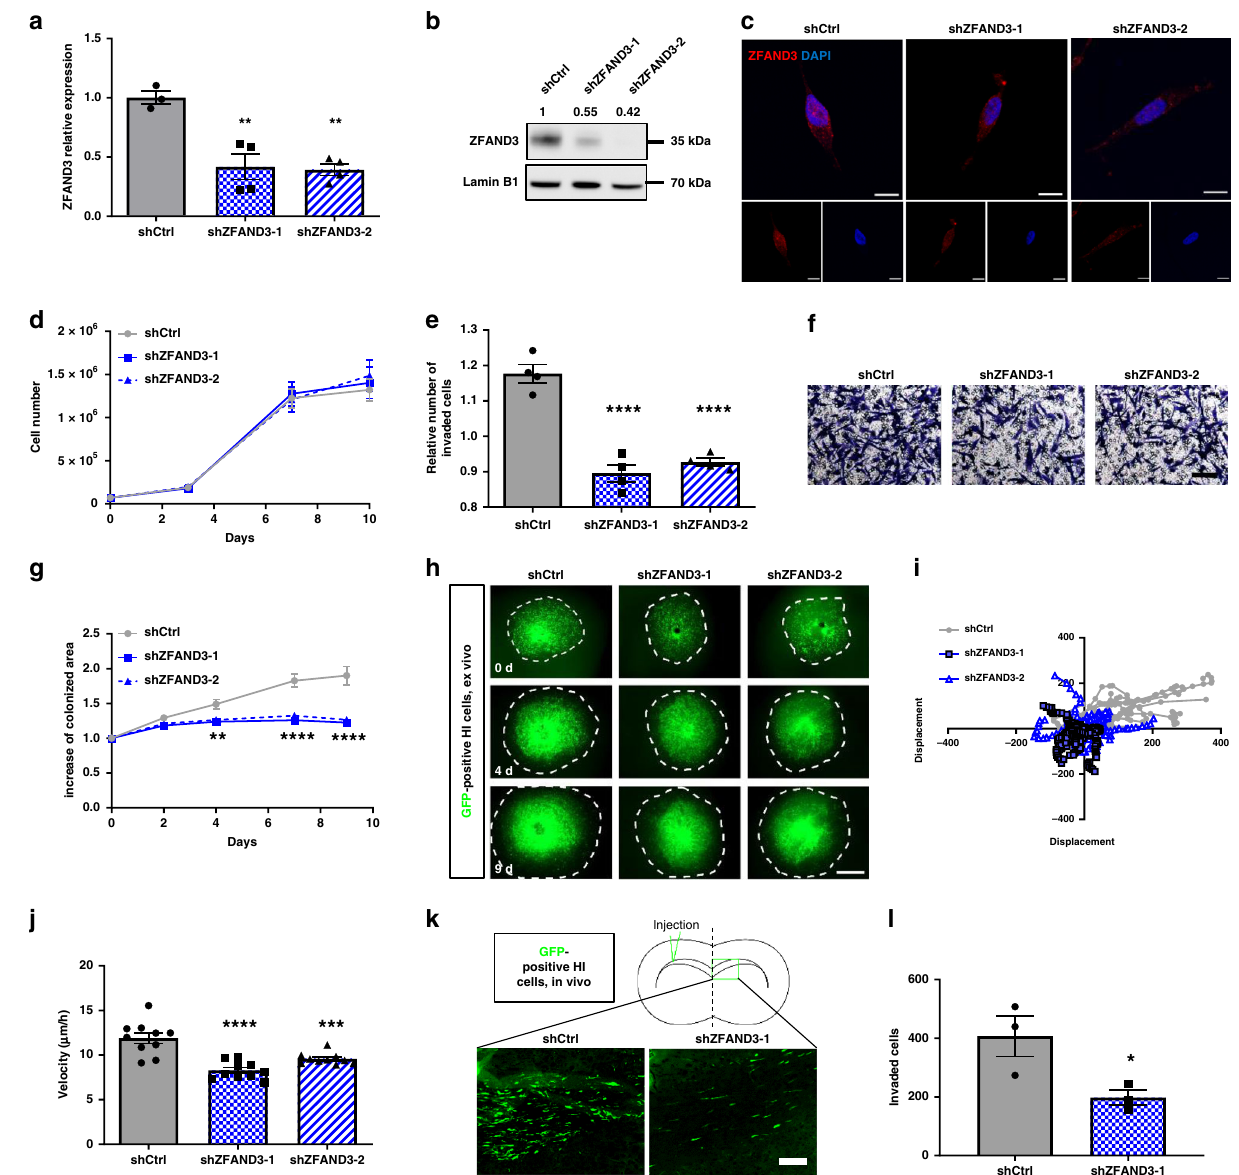
Fig. 3 Knockdown of ZFAND3 decreases invasion capacity of highly-invasive GBM cells. a qPCR con fi rming knockdown (KD) of ZFAND3 in highly invasive GCSs (HI) using two ZFAND3 shRNAs ( n ≥ 3 biologically independent samples). Results are displayed as average ± SEM and were analysed with one-way ANOVA. b , c Decrease of ZFAND3 protein in ZFAND3 KD by western blot ( n = 3) and IF staining (red: ZFAND3, blue: DAPI. Scale bars = 10 µ m) ( n = 2). In analogy to patient samples, ZFAND3 protein is present in the nucleus and cytoplasm. d Growth curves of control and ZFAND3 KD cells show no defect in cell proliferation ( n = 3 biologically independent experiments). e , f Boyden chamber invasion assay showing reduced invasion in ZFAND3 KD cells compared to control ( n = 4 biologically independent experiments) (Scale bar = 100 µ m). Results are displayed as average ± SEM and were analysed with one-way ANOVA. g , h ZFAND3 KD cells implanted in ex vivo brain slice cultures showed reduced colonization compared to control cells, 9 days after tumor implantation ( n = 10 biologically independent samples) (Scale bar = 1000 µ m). Results are displayed as average ± SEM and were analysed with a two-way ANOVA. i , j Visualization and quanti fi cation of single cell displacement of ZFAND3 KD cells in ex vivo brain slice cultures showing reduced velocity compared to control ( n = 15 cells over 10 biologically independent samples). Results are displayed as average ± SEM and were analysed with one- way ANOVA. k , l Upon intracranial implantation ( n = 3 biologically independent animals), ZFAND3 KD cell invasion toward the contralateral hemisphere was decreased compared to control tumors. GBM xenografts were analyzed at 2 months post-surgery (3 sections per mouse) (Scale bar = 100 µ m). Results are displayed as average ± SEM and were analysed with an unpaired, two-sided t test. * p value < 0.05, ** p value < 0.01, *** p value < 0.001, **** p value < shCtrl HI cells (FDR < 0.05, logFC < − 0.5) (Fig. 6a, b, Supplemen- COL6A2 (alpha-2 subunit of type VI collagen), EGFR (epidermal tary Fig. 7a, b). Gene ontology analysis associated these DEGs with growth factor receptor), FN1 ( fi bronectin 1), NRCAM (neuronal cell adhesion and motility-related pathways, such as migration, integrin adhesion molecule) and NRP1 (neuropilin 1), and con fi rmed their complex, ECM and cell adhesion (Fig. 6c). Among these DEGs, we downregulation upon ZFAND3 KD (Fig. 6d – h), thus supporting a selected genes reportedly linked to GBM cell invasion including role for ZFAND3 in transcriptional regulation. To further address